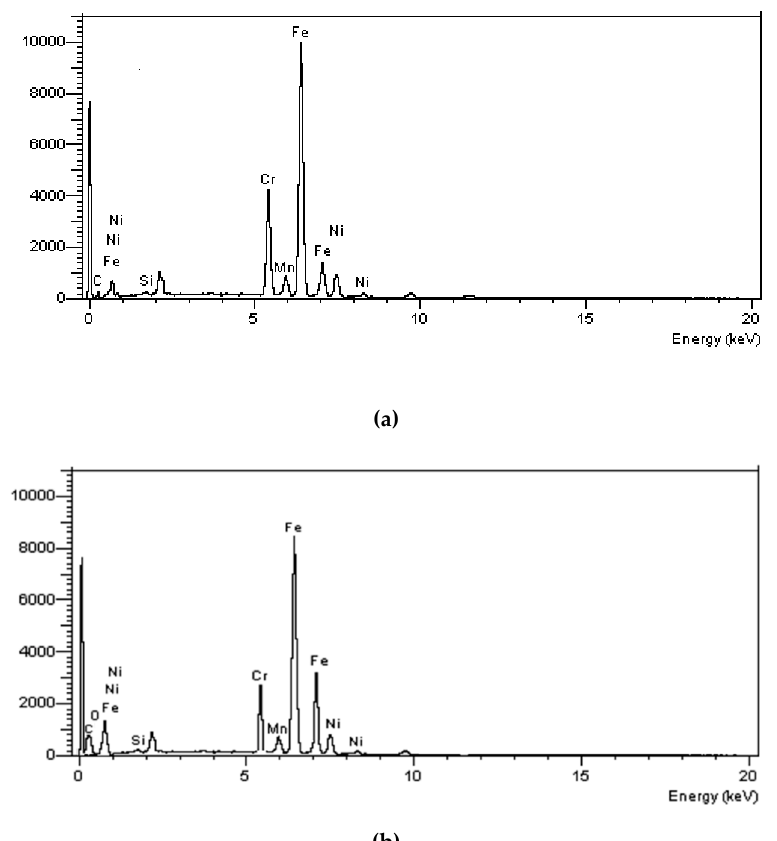
Figure 3. Scanning electron microscopy-energy dispersive X-ray spectrometry (SEM-EDS) analysis of the stainless-steel fiber ( a ) without the acid treatment and ( b ) after acid treatemnt.